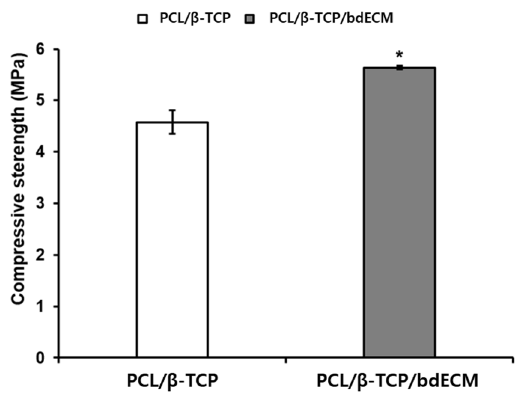
Figure 3. Compressive strengths of the PCL/ β -TCP and PCL/ β -TCP/bdECM scaffolds. The compressive strengths of the PCL/ β -TCP and PCL/ β -TCP/bdECM scaffolds are expressed in white and gray, respectively. In this figure, PCL/ β -TCP/bdECM had a higher compressive strength than PCL/ β -TCP (* p < 0.001).